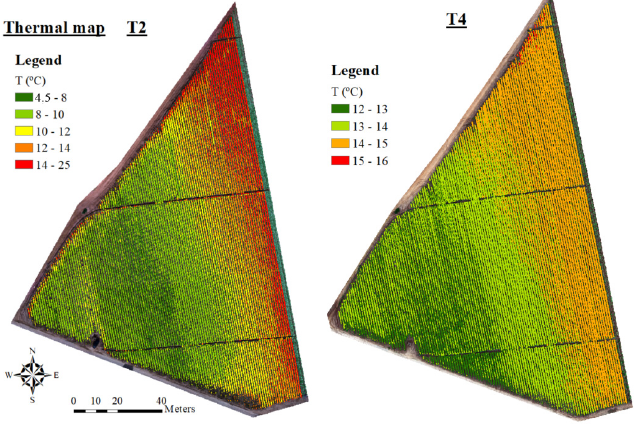
Figure 8. Thermal map of the vegetation for T2 and T4.